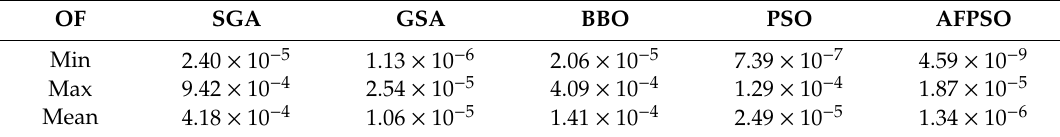
Table 8. Statistical results of optimal fitness obtained by different algorithms in 30 tests (load condition). OF